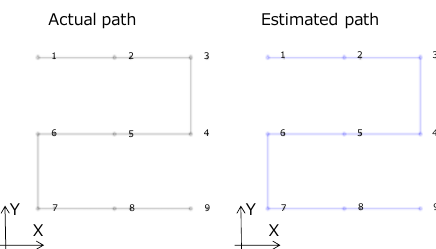
Figure 8. Camera translation estimation result (Room) (Left image: the actual camera path, right image: our estimated result)